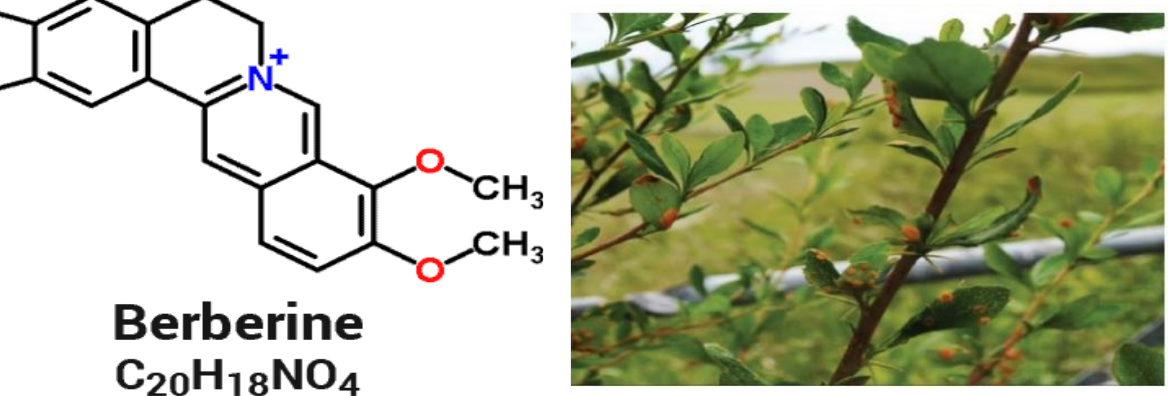
Figure 6. Berberine structure ( left ) and Berberis vulgaris tree ( right ) [50].